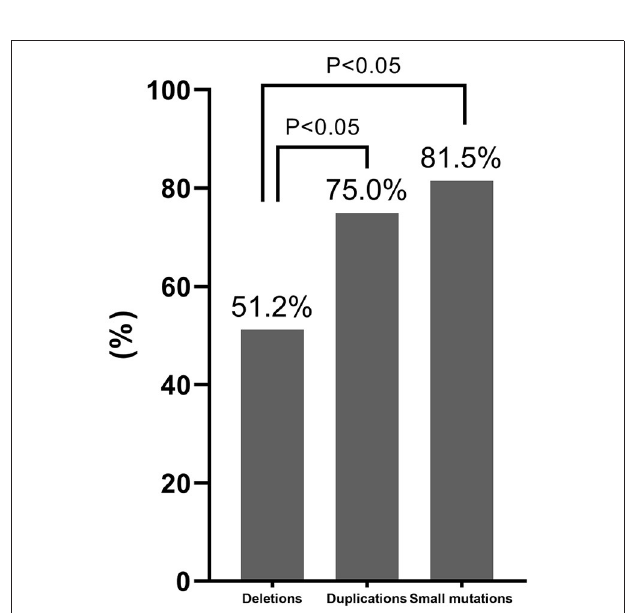
FIGURE 5 | Comparison of the carrier frequency of different variant types. The carrier frequency of deletions was significantly lower than those of duplications and small mutations based on Chi-square test results ( P <